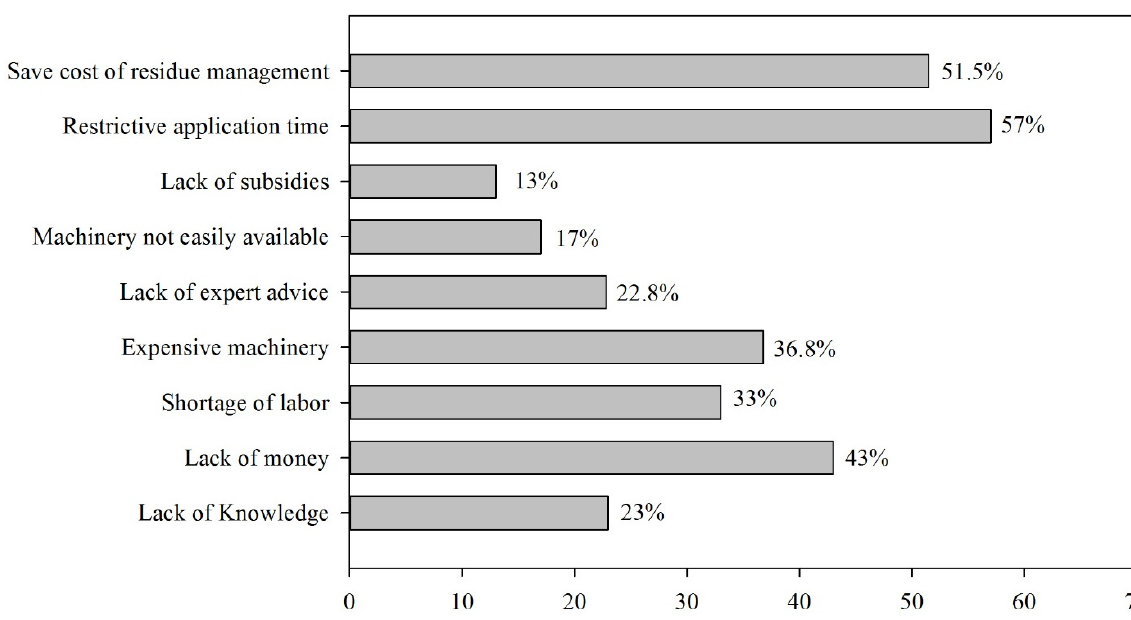
Figure 5. Constraints faced by the farmers.